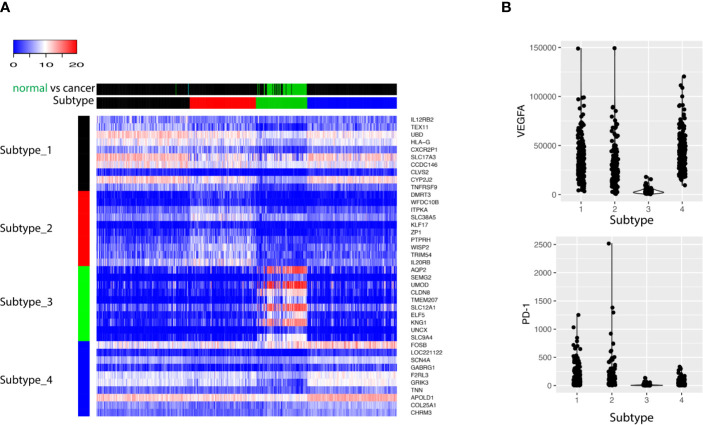

(A) The top 10 biomarkers up-regulated in each subtype were shown as heatmap. Each row represents one gene, and each column stands for one sample. The column side color bar labels the information about the sample. In Subtype bar, Subtype_1, Subtype_2, Subtype_3 and Subtype_4 are colored as black, red, green, and blue, respectively. In normal vs cancer bar, cancer tissue is labeled as black and normal tissue is labeled as green. (B) The expression of VEGFA and PD-1 was shown for the four subtypes: Subtype_1, Subtype_2, Subtype_3, and Subtype_4.